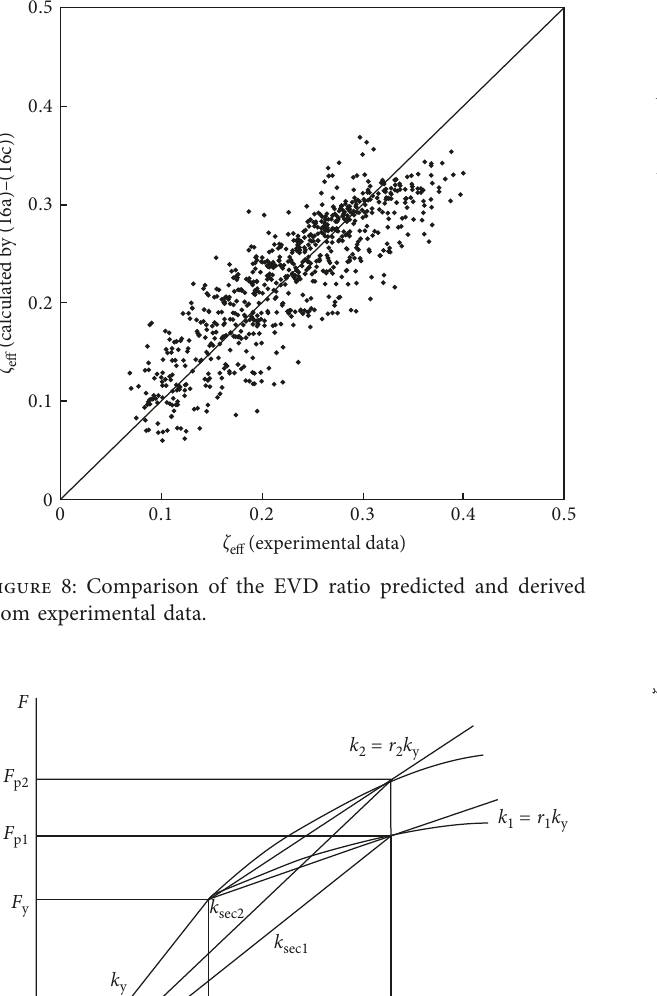
Figure 11: EVD ratio predicted by (16a)–(16c) and (18) versus ductility